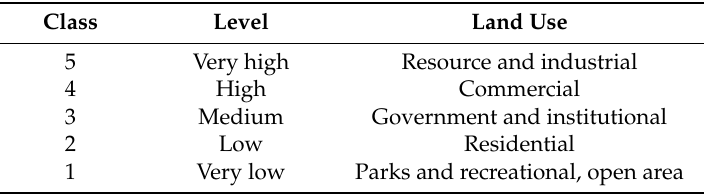
Table 5. Classes for economic vulnerability.